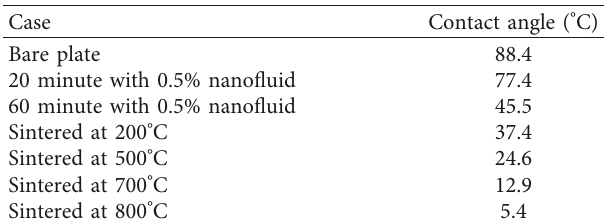
CA left = 12.945 right = 12.327